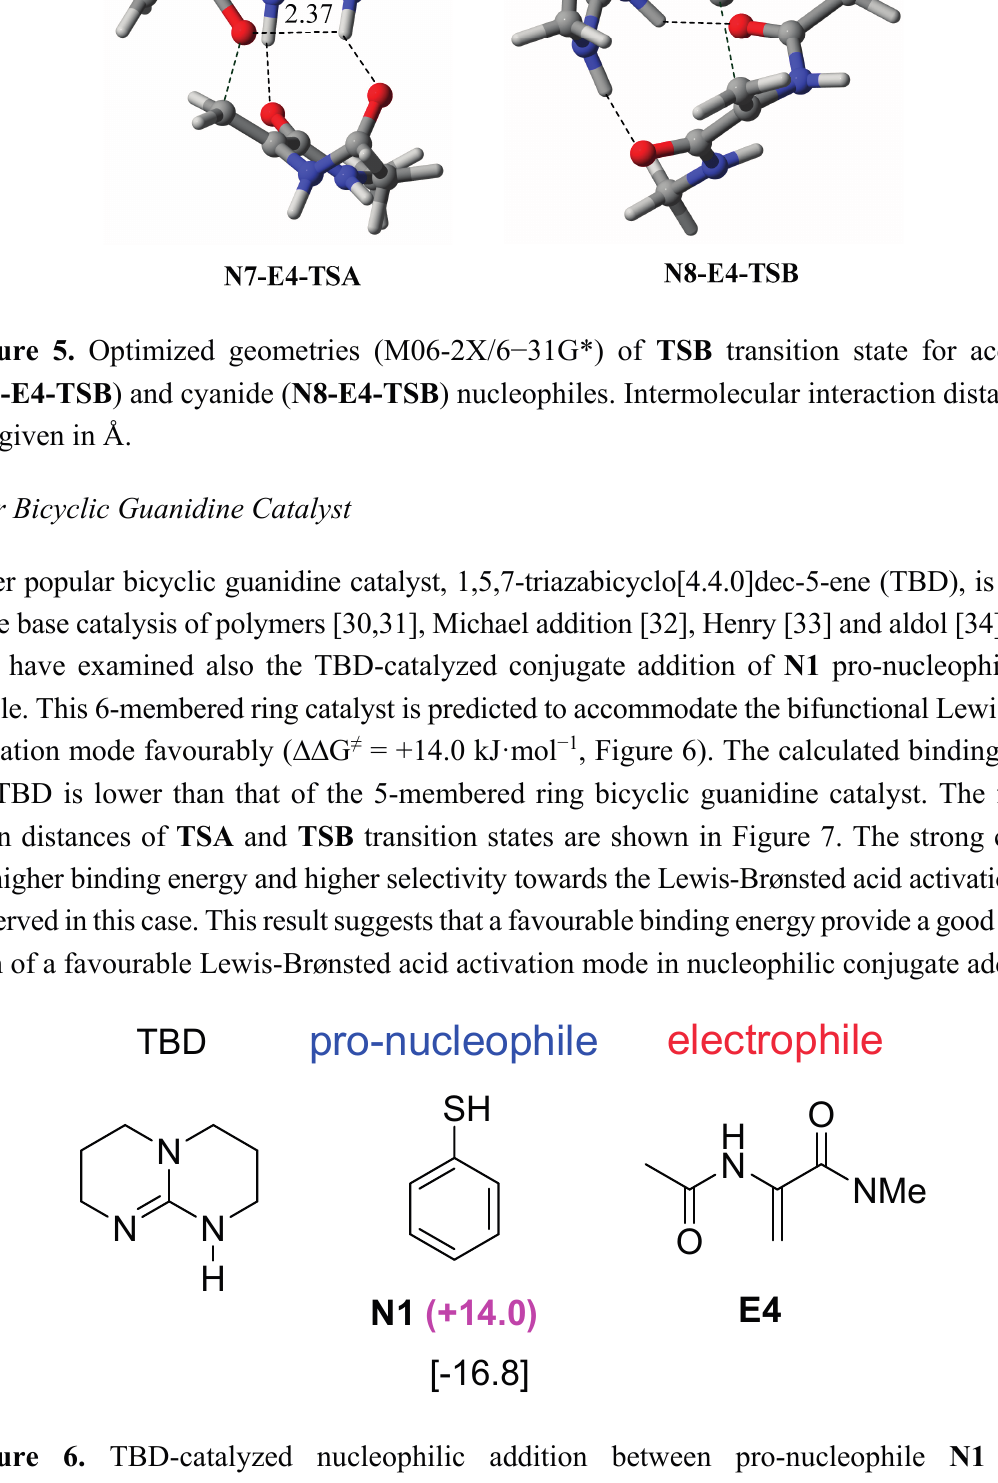
Figure 6. TBD-catalyzed nucleophilic addition between pro-nucleophile N1 and electrophile E4 . ∆∆ G ≠ value (in kJ · mol − 1 ) is given in parenthesis and binding free energy (in kJ · mol − 1 ) is in square